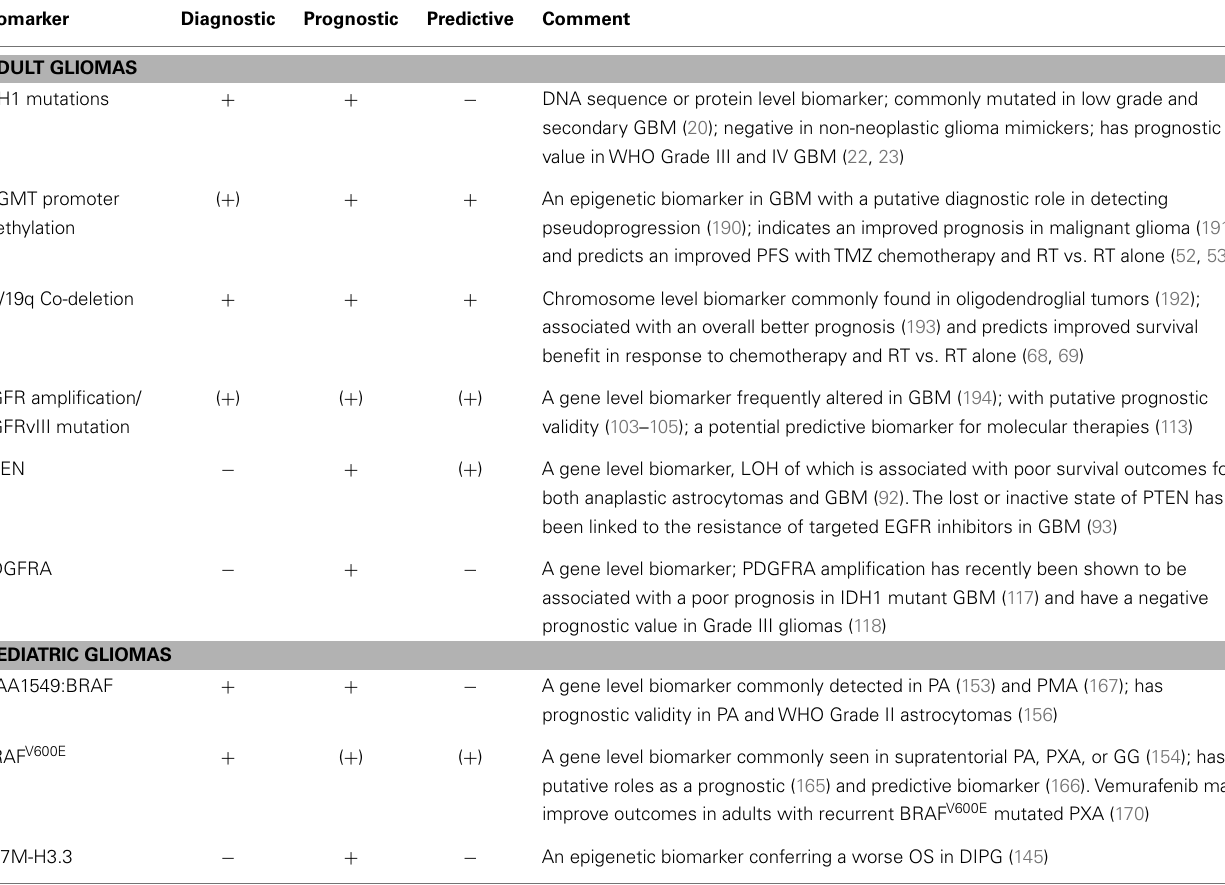
Table 1 |Tissue biomarkers with current clinical or promising relevance in malignant